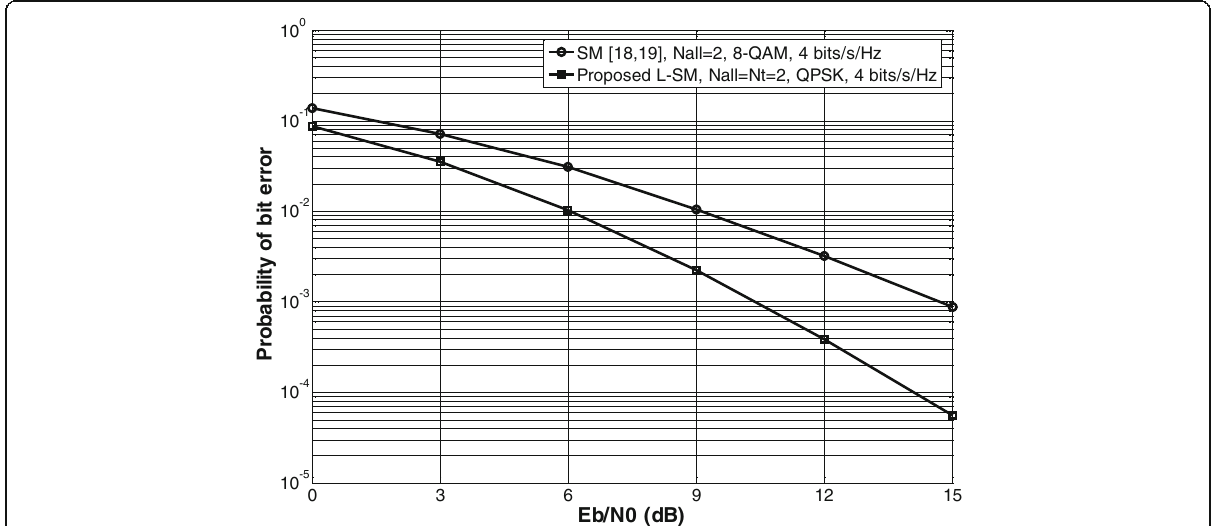
Fig. 3 Performance comparison of the SM and proposed L-SM schemes with N r = 2 for 4 bits/s/Hz